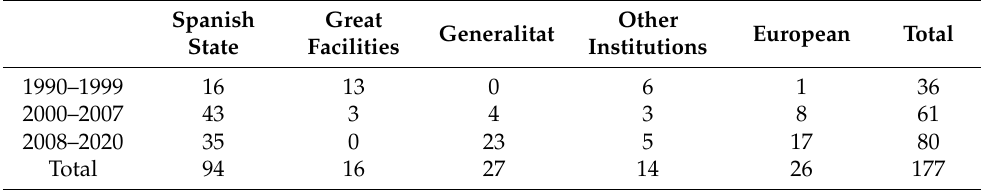
Table 4. Number of competitive projects with funds awarded to SARTI-UPC.